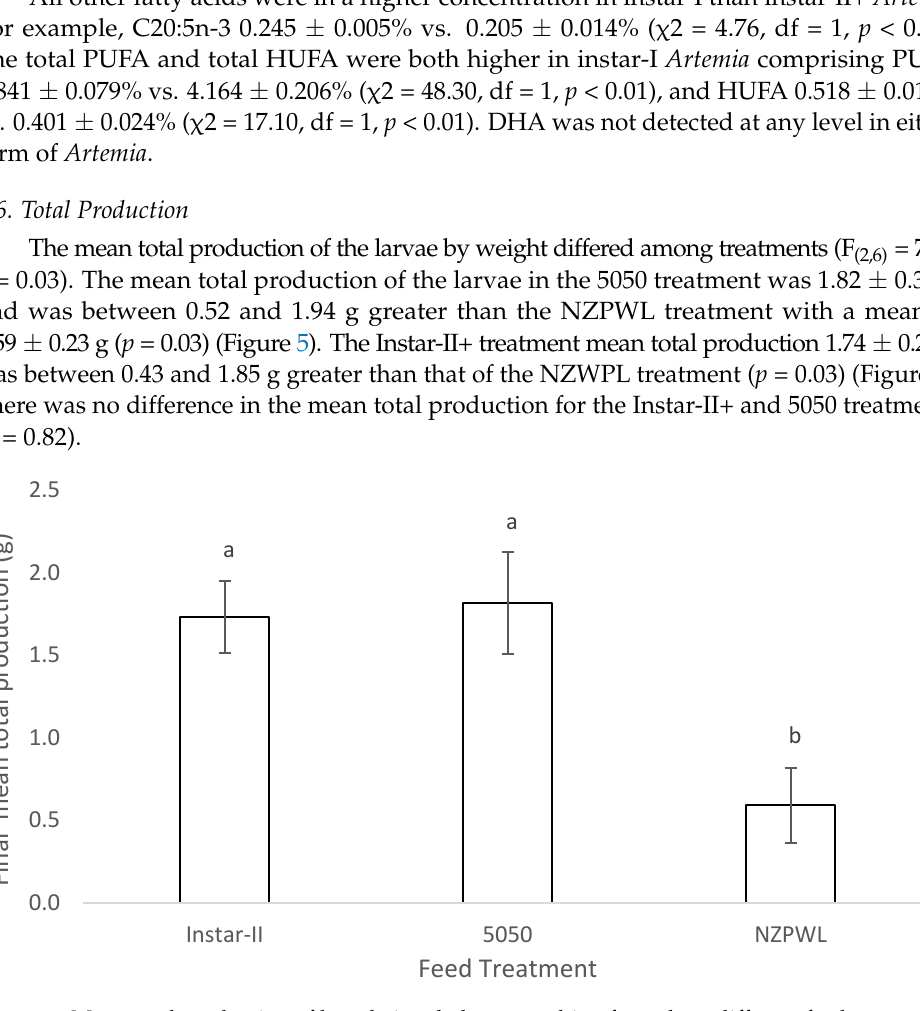
Figure 5. Mean total production of larval giant k¯okopu resulting from three different feed treatments, Instar-II+, 5050, and NZPWL, over the 28-day experimental period (mean ± SE). Means with different superscripts are significantly different ( p < 0.05).